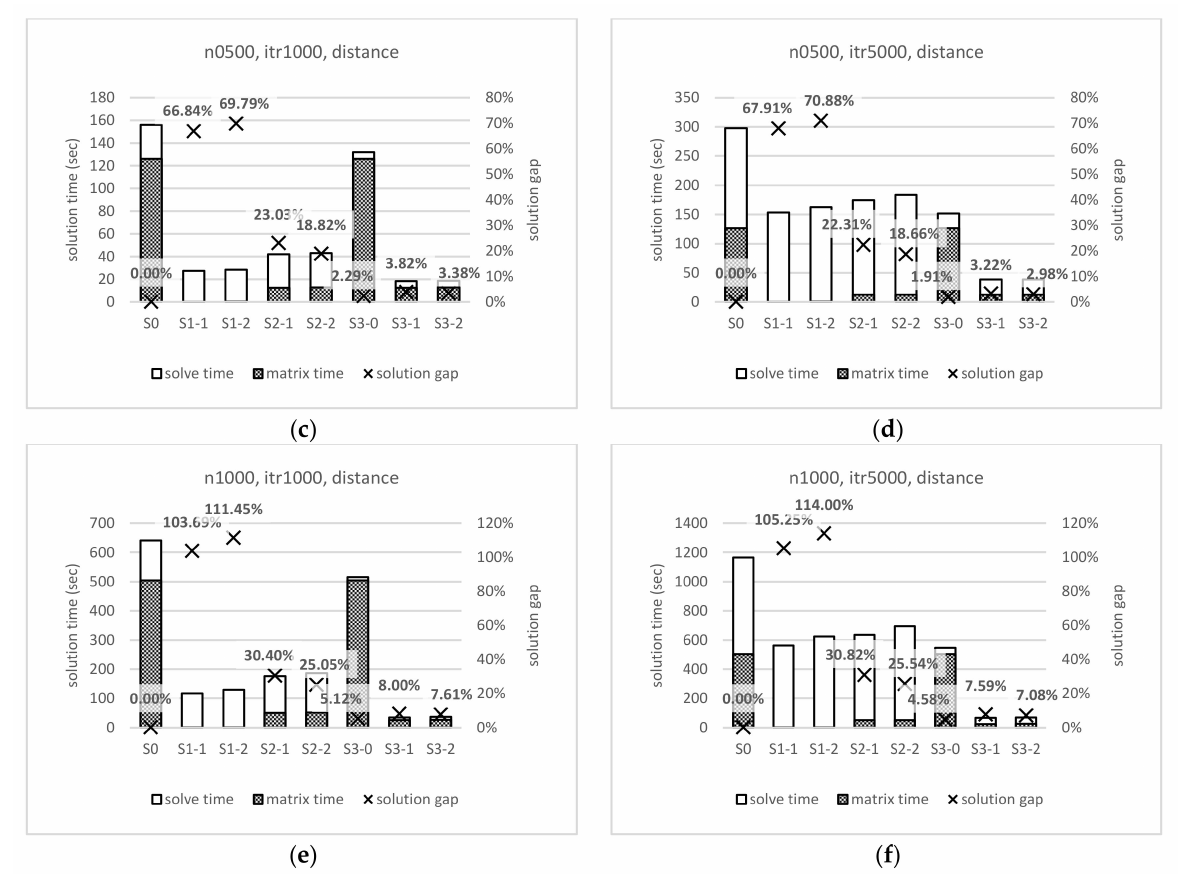
Figure 11. Solution time and gap for experimental scenarios with cost matrix type of